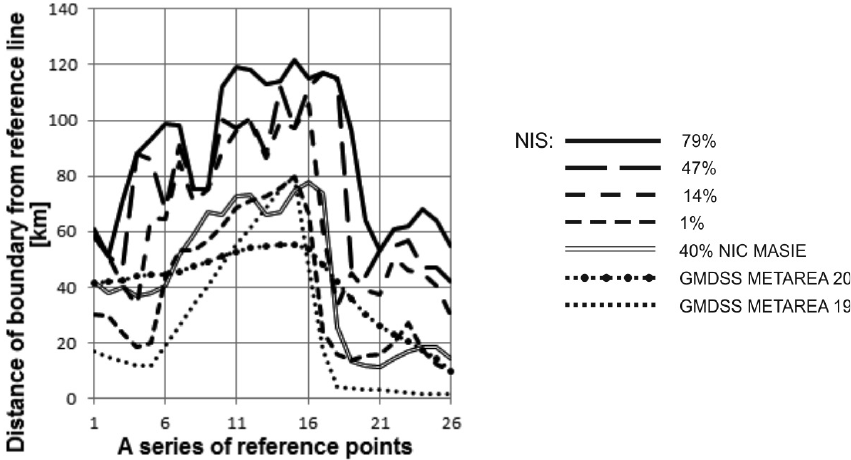
Fig. 7. Distances of boundaries from the reference line (developed by the author)